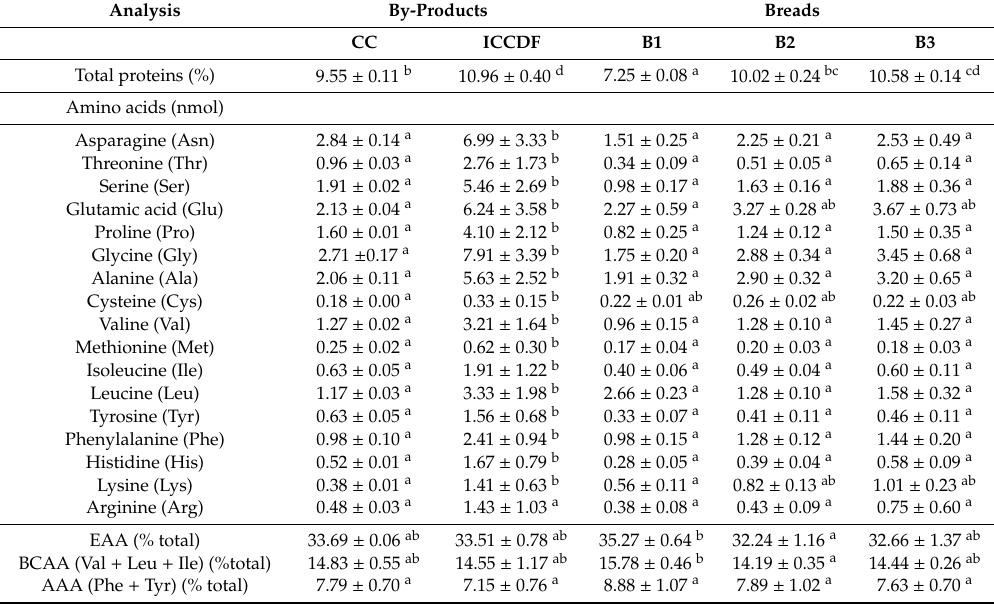
Table 2. Total protein (%) and amino acid content (nmol) of co ff ee cascara (CC), insoluble co ff ee cascara dietary fiber (ICCDF) and breads enriched with ICCDF (B1, B2 and